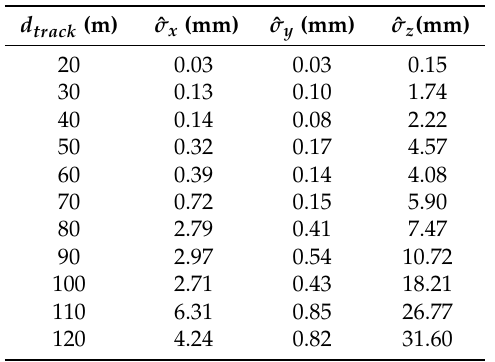
Table 5. Empirical standard deviation ˆ σ C for d base ≈ 3 m.